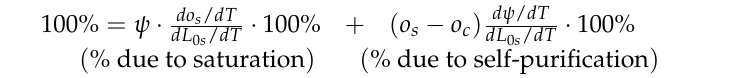
Figure 9. Plot of the temperature sensitivity of the sustainable mixing-point concentration as a function of temperature for freshwater rivers at several elevations and self-purification constants.